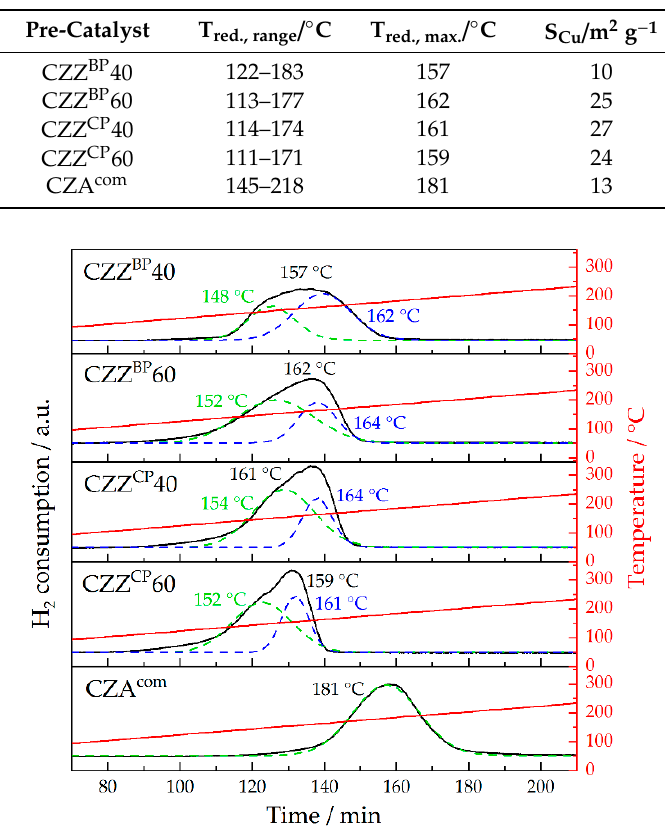
Table 3. H 2 -TPR and N 2 O-RFC measurements (H 2 -TPR: 5% H 2 / Ar, 1 K min − 1 , RT–300 ◦ C, N 2 O-RFC: Table 3. H 2 ‐ TPR and N 2 O ‐ RFC measurements (H 2 ‐ TPR: 5% H 2 /Ar, 1 K min − 1 , RT–300 °C, N 2 O ‐ RFC: 1% N 2 O / He, RT). 1% N 2 O/He, RT).